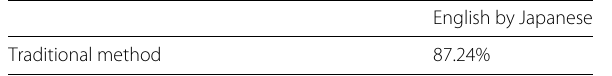
Table 5 Results of conducted experiments for the traditional method (baseline) Traditional